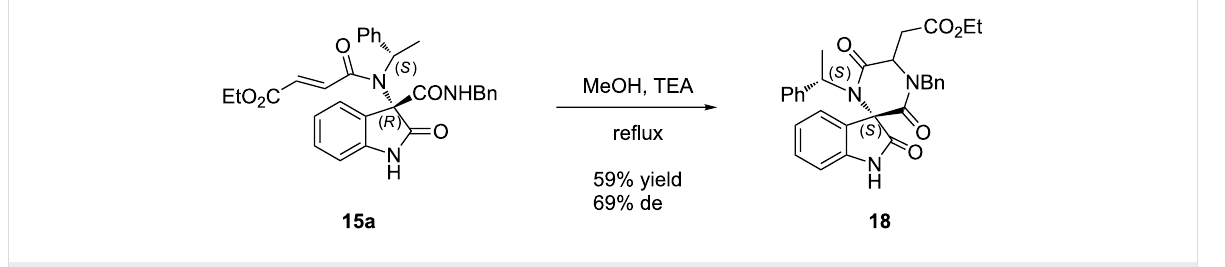
Scheme 2: Post-Ugi cyclization on compound 15a